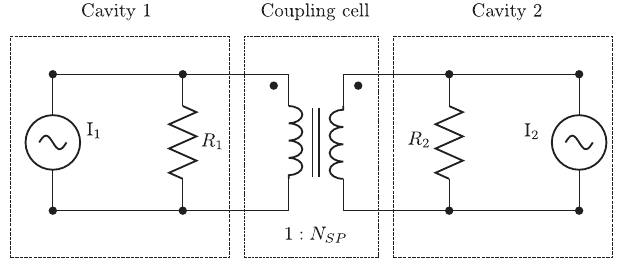
FIG. 4. A circuit diagram of the dual axis